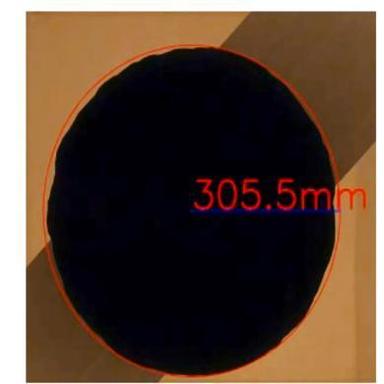
Shows the deviations of the automatic measurement technique by an idealised circle in contrast to the actual contour of the final slump flow.